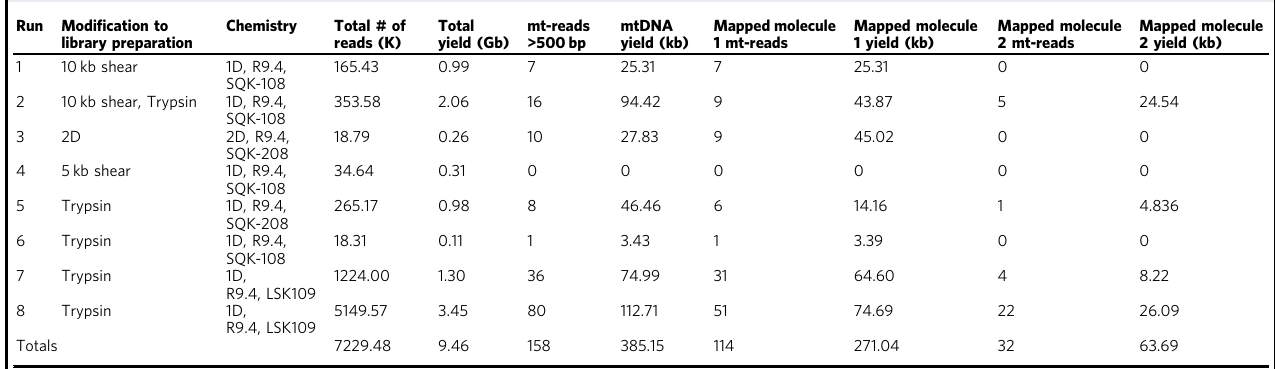
Table 1 Data obtained from Oxford Nanopore runs both mined and retrieved mitochondrial DNA (see text for protocol information).